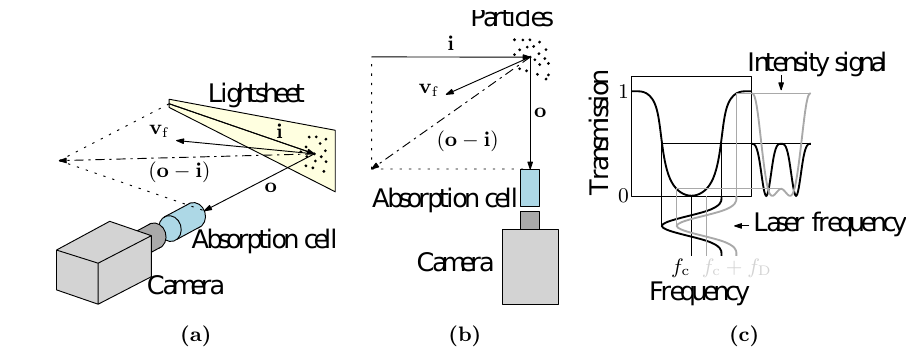
Figure 2. FM-DGV measurement principle: (a) and (b) the particles are illuminated from the direction i , and the scattered light is detected behind a caesium absorption cell. (c) Due to the frequency-dependent transmission curve of the caesium gas, the Doppler frequency shift is transformed into a change of the transmitted light intensity (flow velocity v f , laser centre frequency f c , Doppler frequency f D ).